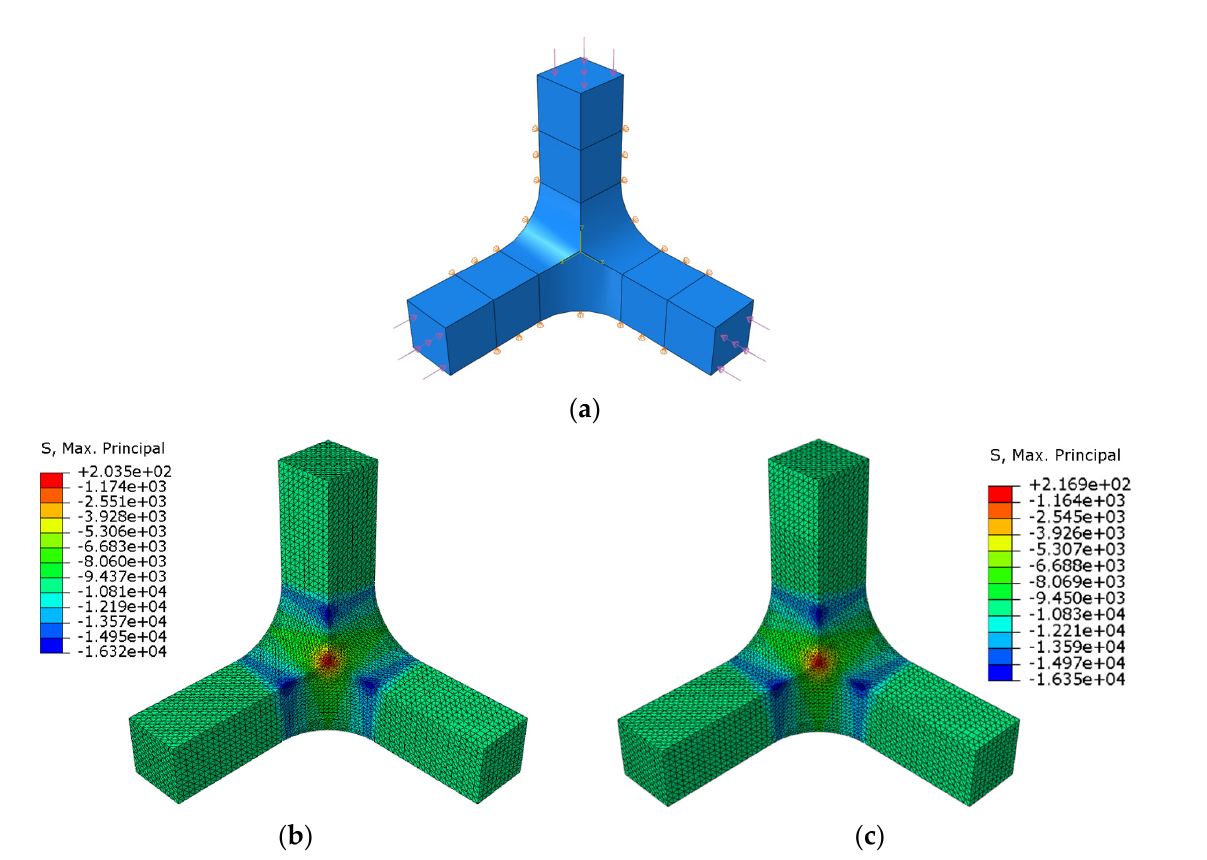
Figure 11. In geometry A for the CCC loading case: ( a ) Boundary conditions imposed by the fixture; ( b ) maximum principal stresses with ideal boundary conditions; and ( c ) maximum principal stresses with the boundary conditions imposed by the fixture.